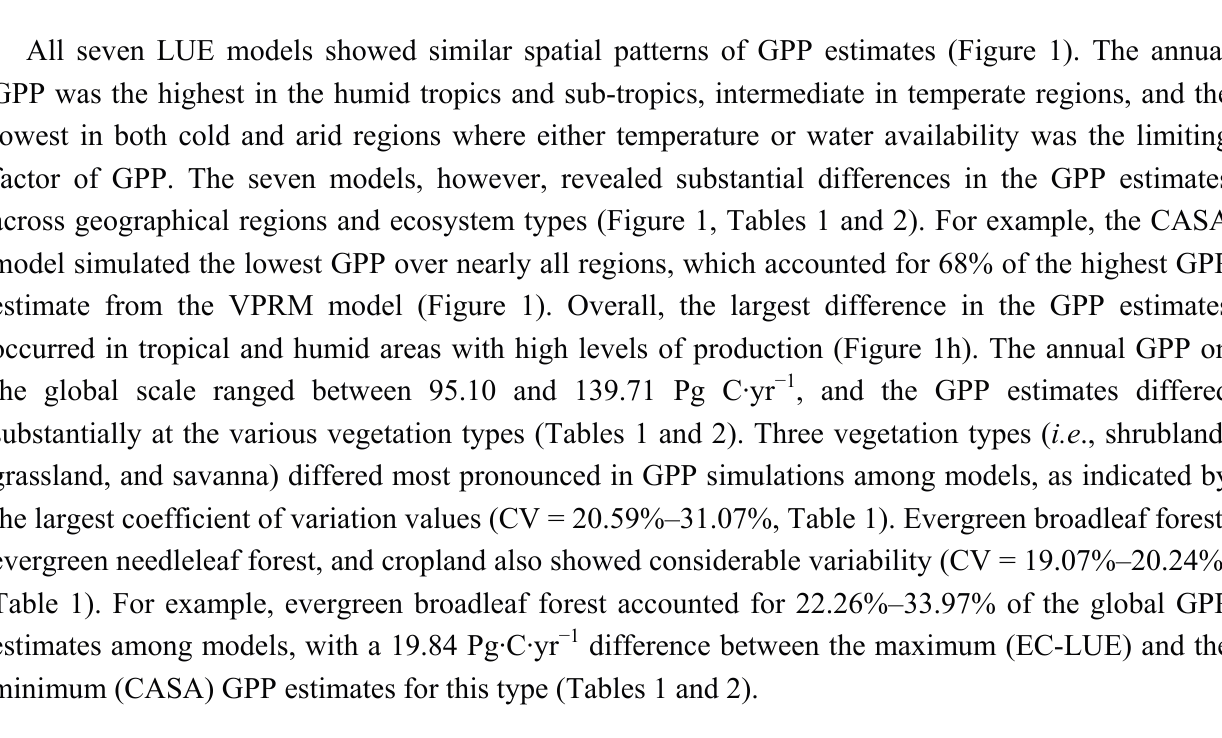
Table 1. The comparison of gross primary production estimates over various vegetation